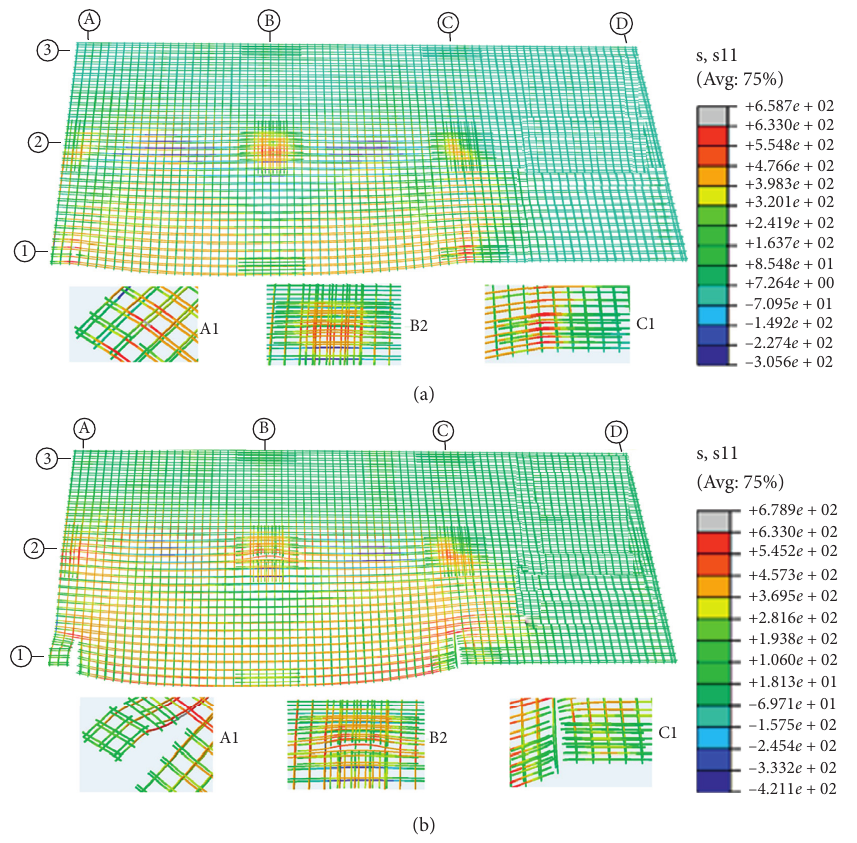
Figure 8: Stress state of the slab bars at stations B (a) and D (b) in model RP.